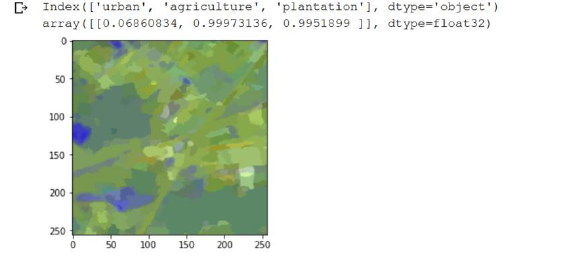
Figure 20 . Result of 256 X 256 Fused Image.